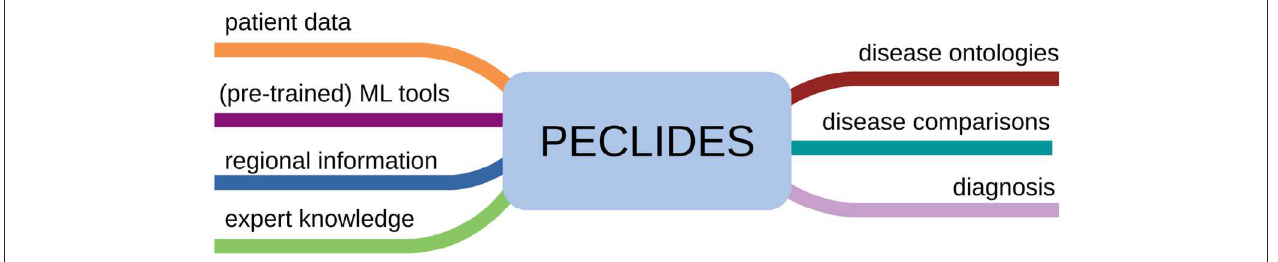
FIGURE 11 | Overview of possible applications of the PECLIDES library. On the left several different inputs to the algorithm are shown. Patient data, (pre-trained) machine learning (ML) tools, specific relevant regional information and expert knowledge can be used as input. And the algorithm can provide different outputs, which can be related to disease ontologies or disease comparisons or a